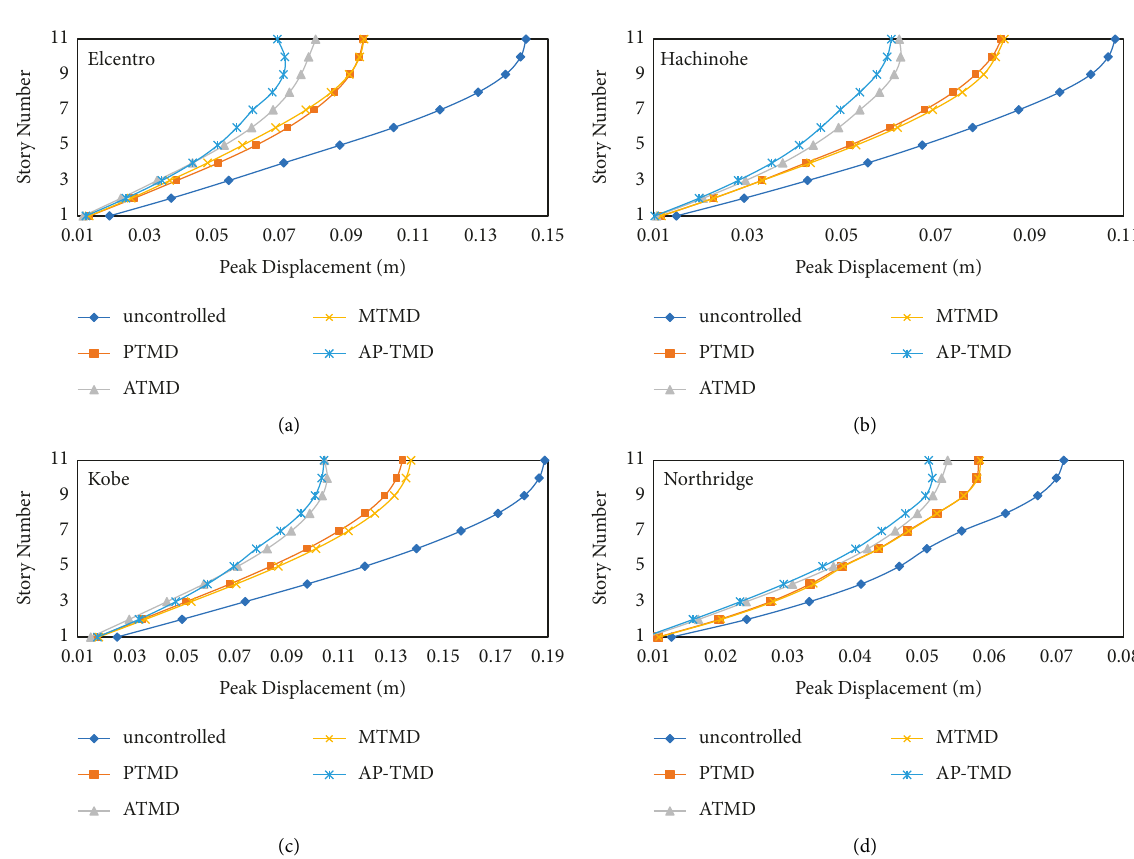
Figure 12: Maximum displacement of structures with different controllers under 4 earthquakes. (a) Maximum displacement of structure under El Centro earthquake. (b) Maximum displacement of structure under Hachinohe earthquake. (c) Maximum displacement of structure under Kobe earthquake. (d) Maximum displacement of structure under Northridge earthquake.